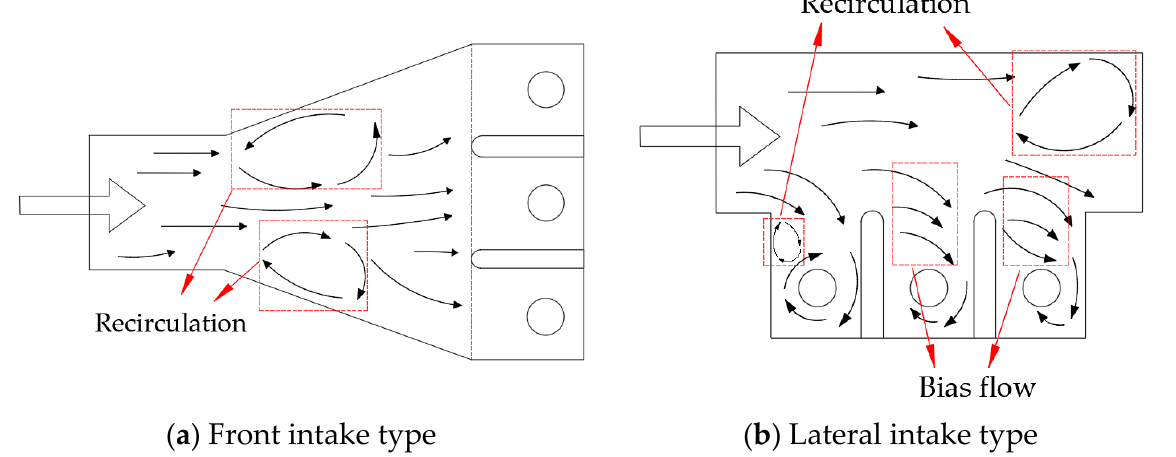
Figure 1. Flow pattern in the forebay and sump of front and lateral intake pumping station (ref arrows mean the flow direction).